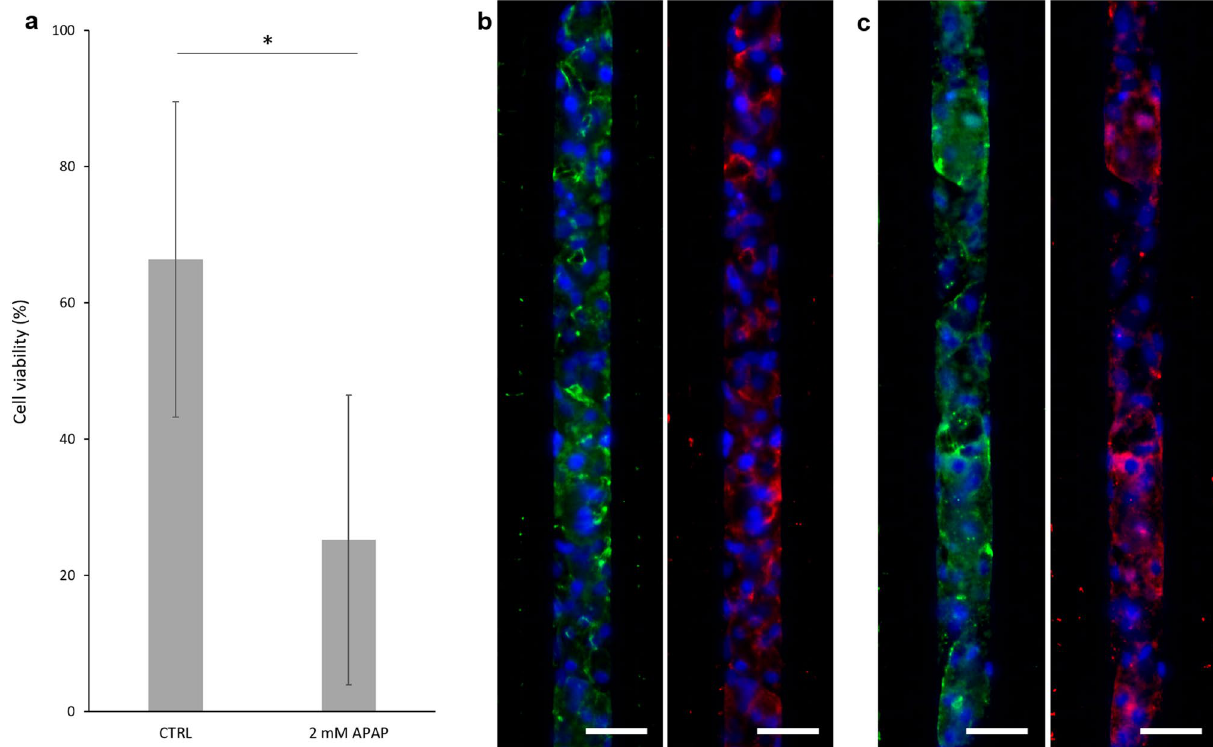
Figure 6. Chip response to acetaminophen (APAP) exposure. Differentiated HepaRG were loaded and culture on chip for 14 days, then exposed to 2 mM APAP for 6 days. Their viability was assessed by a Live and Dead test, they were then fixed and stained for nuclei (blue), ZO-1 (green) and MDR3 (red). ( a ) Cell viability in control and treated chips (CTRL n = 3 chips, 2 mM APAP n = 2 chips). Immunofluorescent images of ( b ) a control